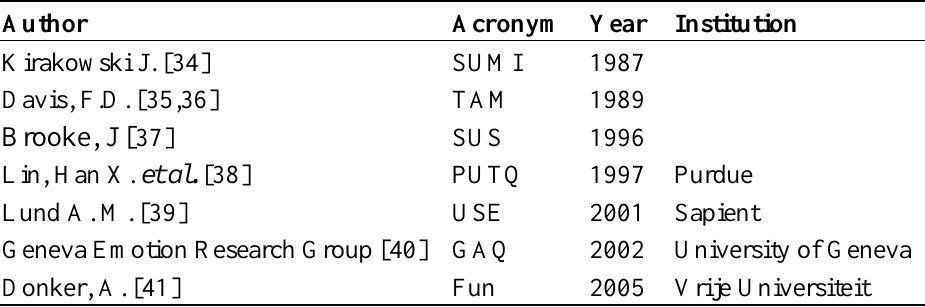
Table 3. Usability questionnaires